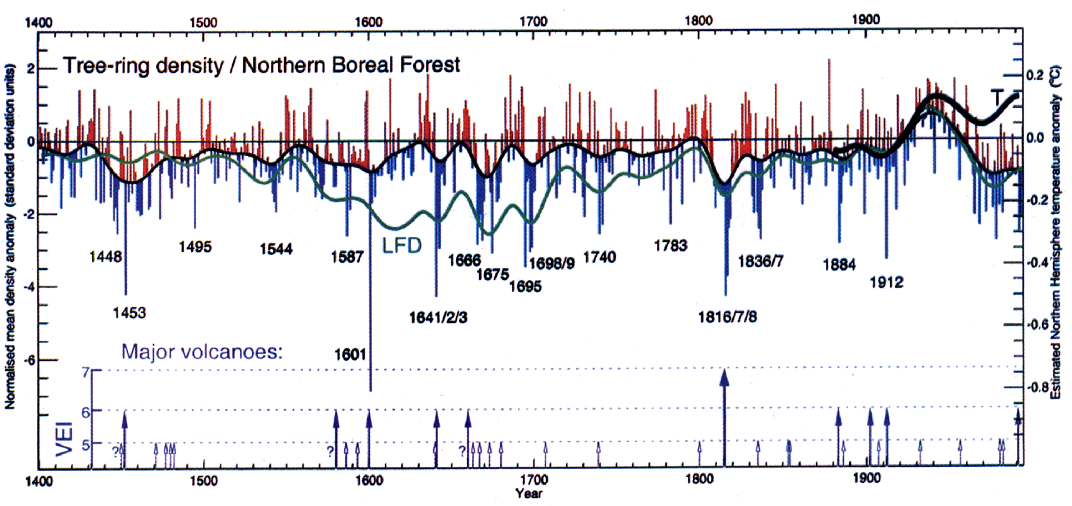
FIGURE 4. Growing season temperature changes in the northern hemisphere (T) as associated with volcanic eruptions over the last 600 years based on yearly average of maximum tree-density (histogram) [51]. LFD indicates low-frequency density changes. See [51] and references therein for details on use of LFD. Large volcanic eruptions indicated by the Volcanic Explosivity Index (VEI)[66]. Reprinted from Quaternary Science Reviews , 19 , Annual climate variability in the Holocene: Interpreting the message of ancient trees, 87-105, 2000, with permission from Elsevier Science. Initial permission from Nature